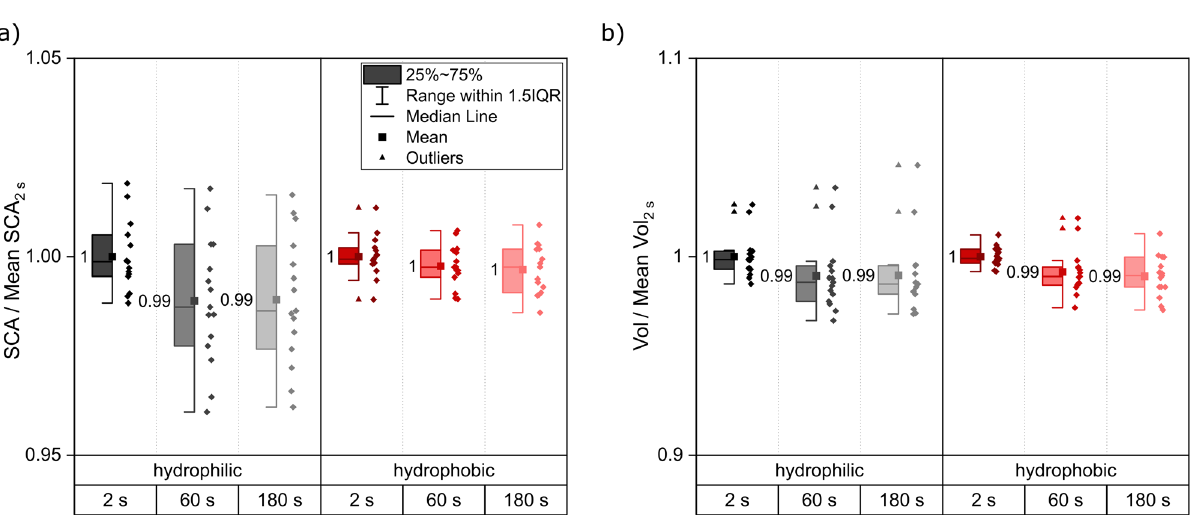
Figure 12. Static contact angle measurements with 3 µl of water. Five droplets per sample were analyzed on three samples each for both wetting states. Static contact angle ( a ) and volume ( b ) were measured 2 s, 60 s and 180 s after application. The reference data for normalization is “2 s”. For both wetting types a separate normalization was carried out. No significant differences were observed between the different measurement times suggesting stable measurement